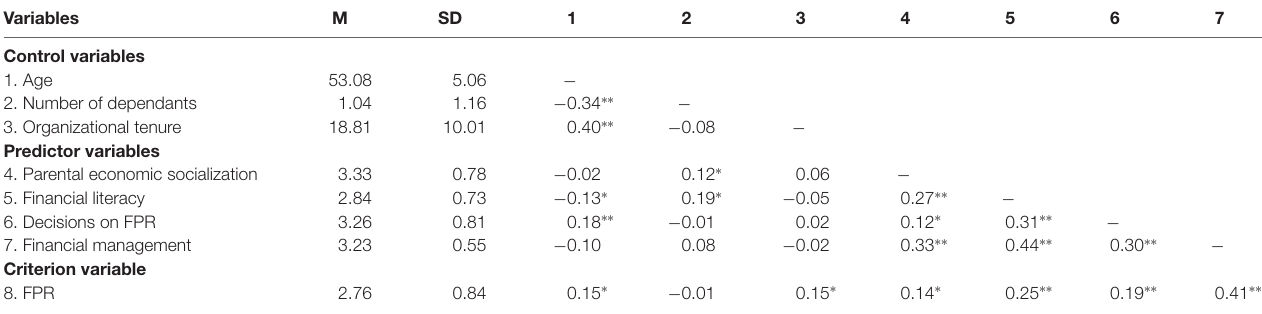
TABLE 1 | Descriptive statistics and correlation matrix of variables ( N = 280).